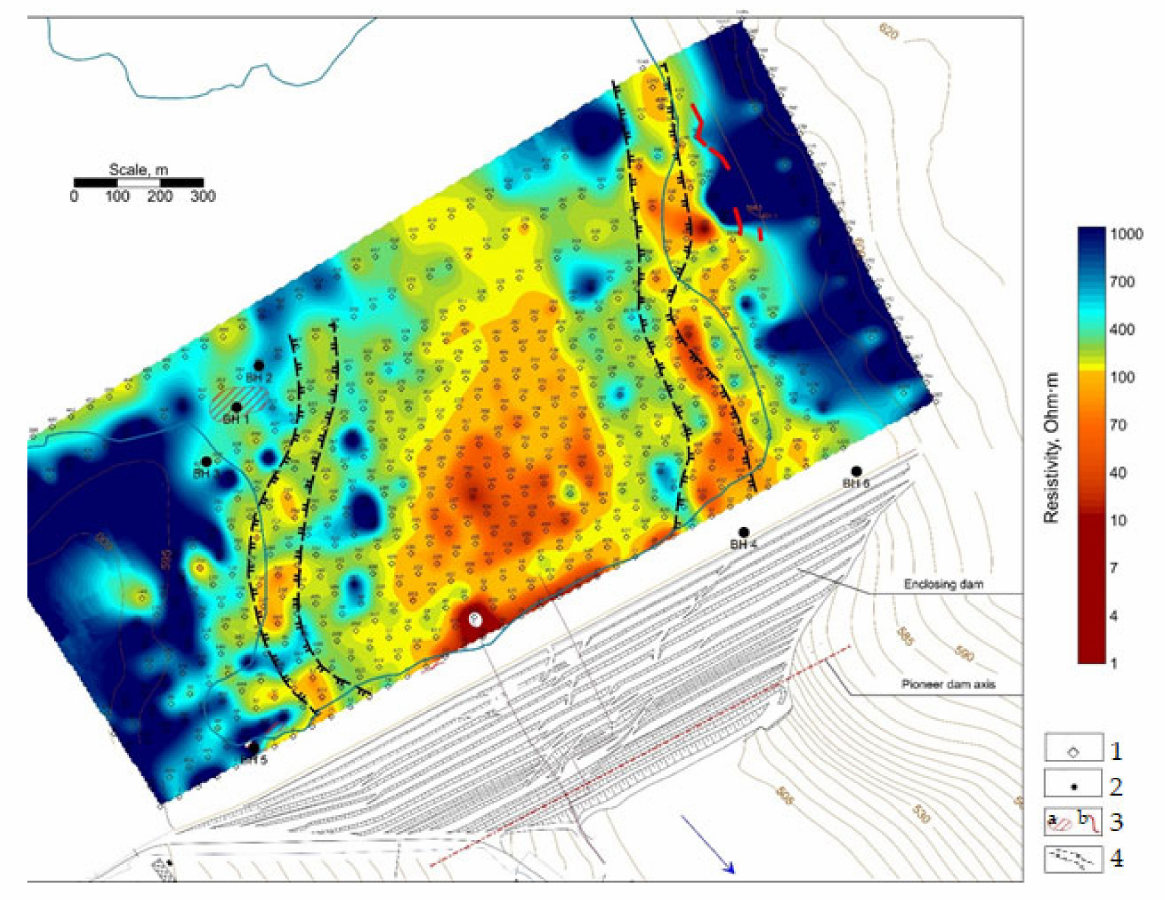
Figure 8. Resistivity distribution map at a depth of 65 m (absolute elevation 530 m). 1—points of the TEM; 2—wells; 3—dips (a) and cracks (b); 4—linear filtration zones according to the TEM data; the blue arrow shows the direction of the filtrate